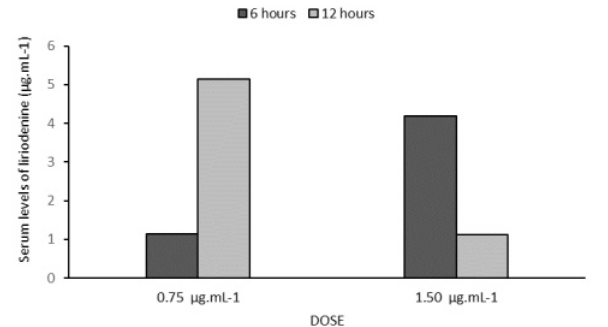
Figure 7. Serum levels of liriodenine were observed at 6 and 12 h after the administration by gavage of both doses of 0.75 and 1.50 mg.kg -1 of body weight. Data from one animal per dose at the time. The serum level is the average of three repetitions performed in each